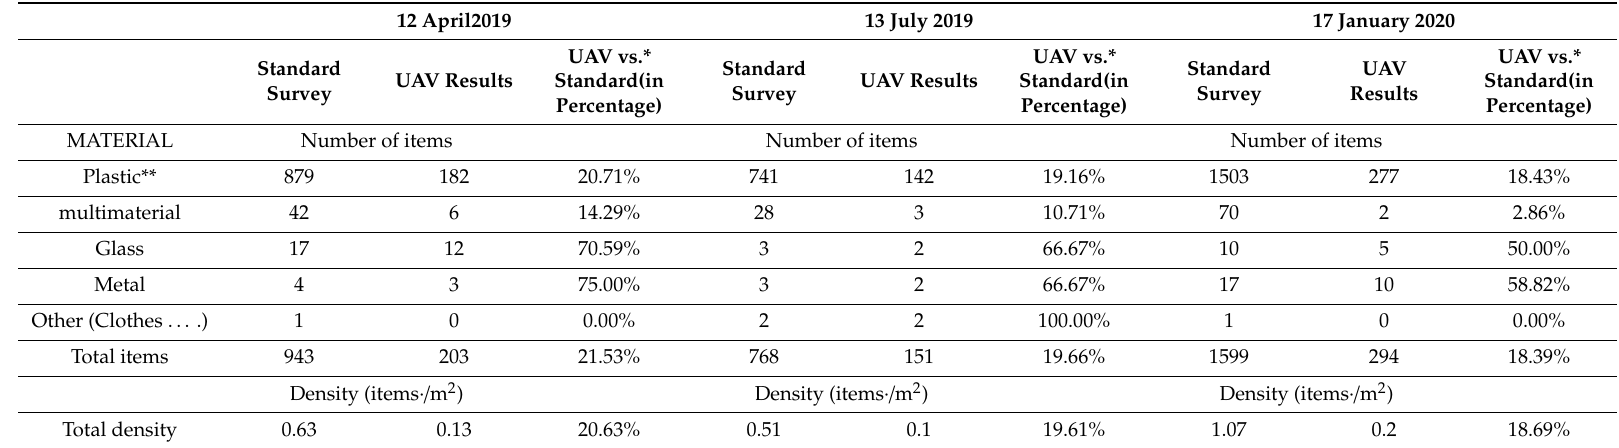
Table 1. Results from manual standard survey of the studied beach, compared with the one obtained from ortho-mosaic (material type classification).